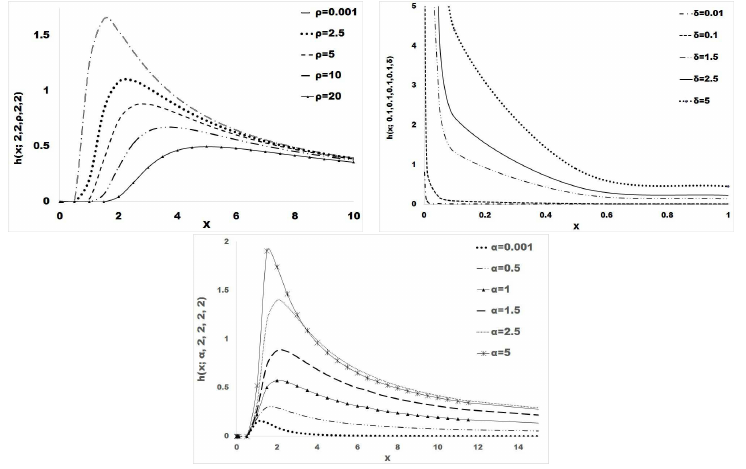
Figure 2 – Plots of the hazard rate function of EKIWD ( α, β, ρ, σ, δ ) for particular values of its